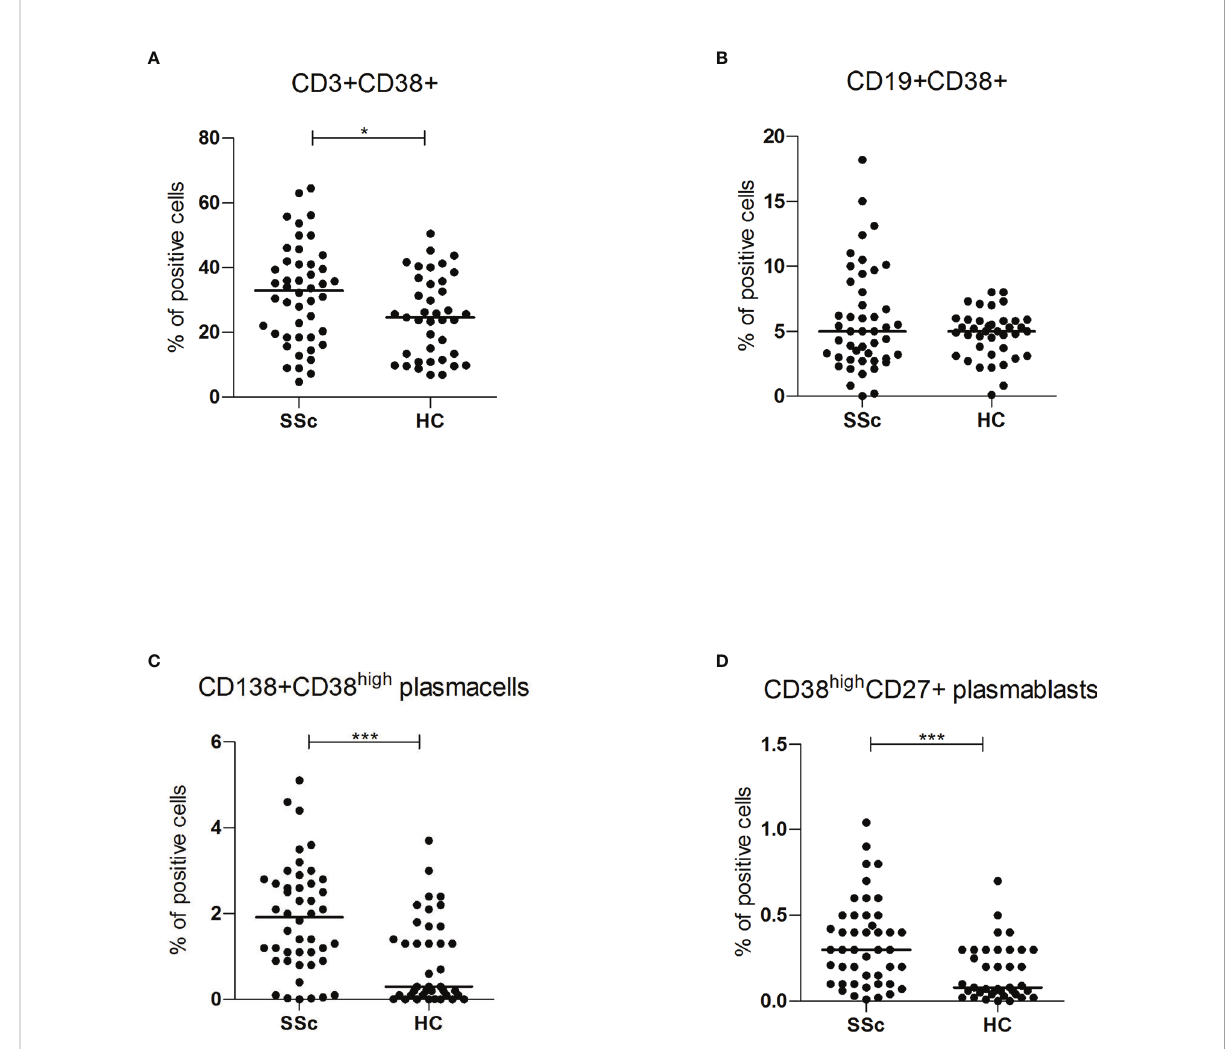
FIGURE 2 (A, B) CD3+CD38+ and CD19+CD38+ surface antigen expression of PBMC from SSc patients (SSc; n = 46) and healthy controls (HC; n = 32) were analyzed by fl ow cytometry. Results are expressed as percentage of positive cells. Horizontal bars represent median values; *= p < 0.05; *** = p < 0.001. Mann-Whitney test was used for inter-groups analysis; (C, D) CD138+CD38 high and CD38 high CD27+ surface antigen expression of PBMC from SSc patients (SSc; n = 46) and healthy controls (HC; n = 32) were analyzed by fl ow cytometry. Results are expressed as percentage of positive cells. Horizontal bars represent median values; *= p < 0.05; *** = p < 0.001. Mann-Whitney test was used for inter- groups